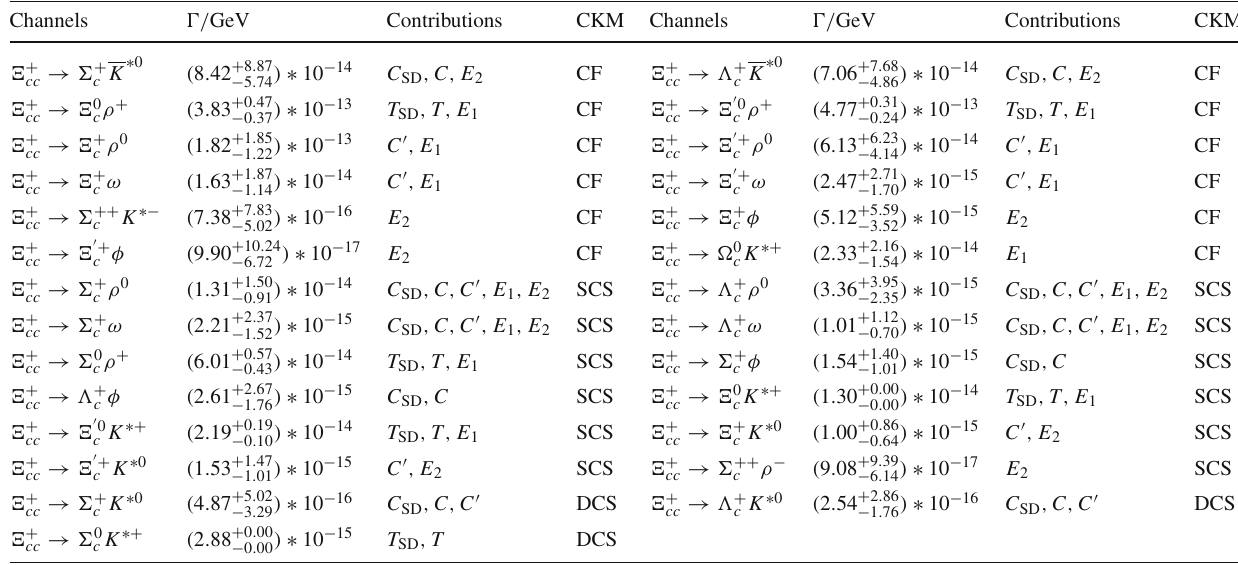
processes, respectively. The errors are estimated by varying η from 1 to 2, and the central values are given at η = 1 .